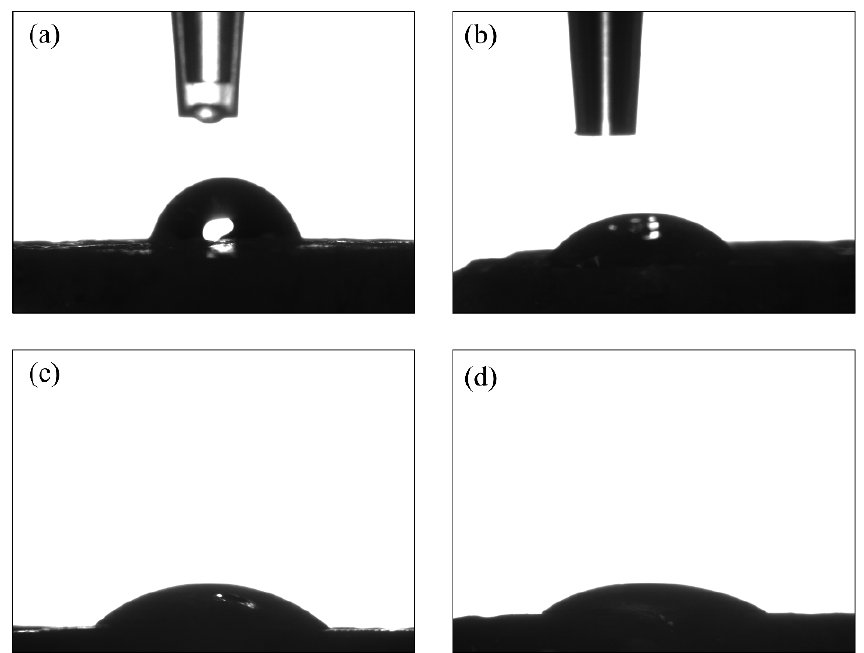
Figure 4. Contact angle measurements for the solvent-cast samples: untreated PLGA using ( a ) water and ( b ) diiodomethane droplets, and plasma-treated PLGA using ( c ) water and ( d ) diiodomethane droplets.